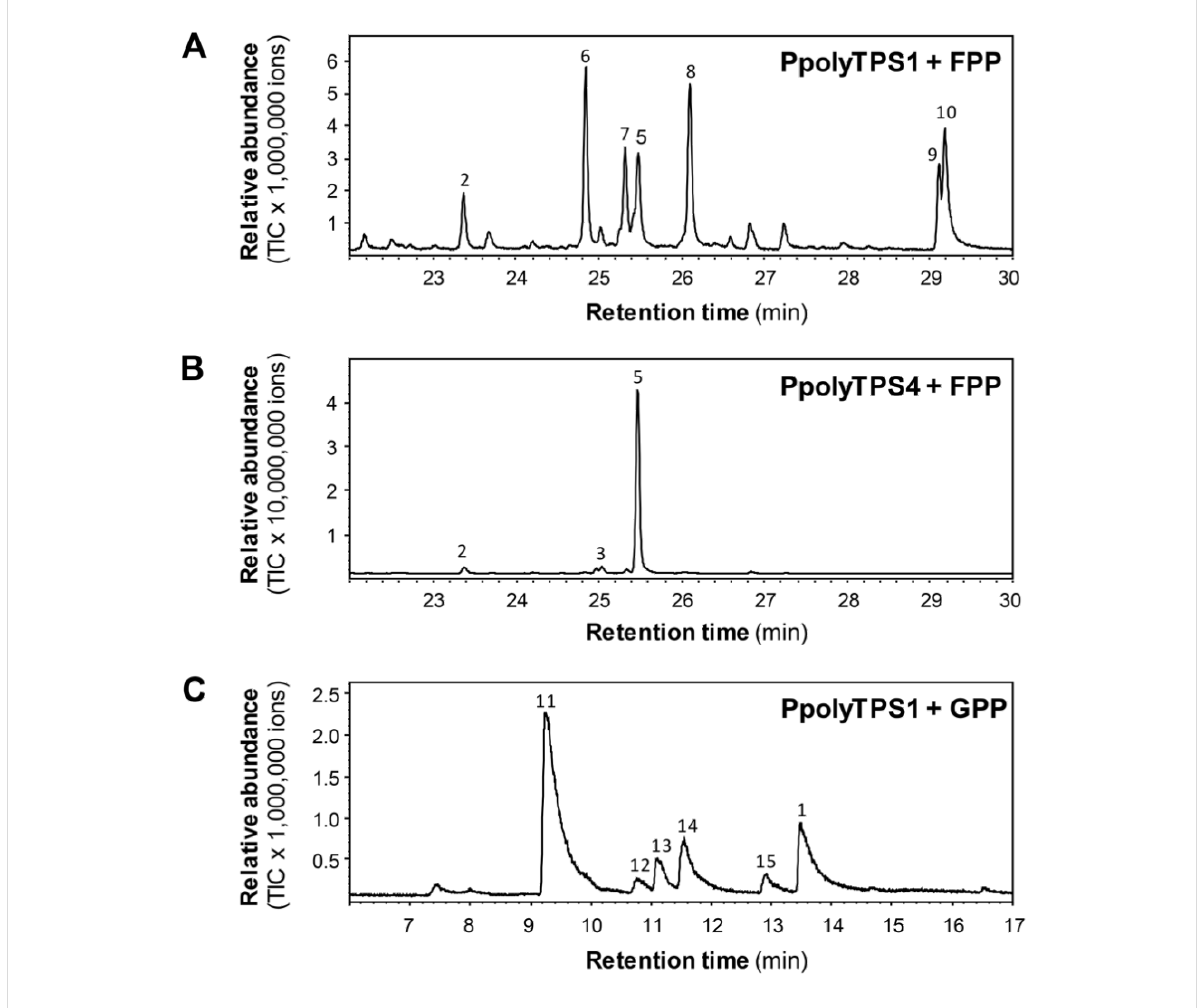
Figure 3: PpolyTPS1 and PpolyTPS4 have terpene synthase activities. A) GC chromatogram of sesquiterpenes produced by recombinant PpolyTPS1 incubated with FPP. 2 , ( E )- β -caryophyllene; 6 , γ -muurolene; 7 , unidentified sesquiterpene 1; 5 , α -muurolene; 8 , unidentified sesquiterpene 2; 9 , unidentified sesquiterpene 4; 10 , unidentified sesquiterpene 5. B) GC chromatogram of sesquiterpenes produced by recombinant PpolyTPS4 incubat- ed with FPP. 2 , ( E )- β -caryophyllene; 3 , unidentified sesquiterpene 3; 5 , α -muurolene. C) GC chromatogram monoterpenes produced by